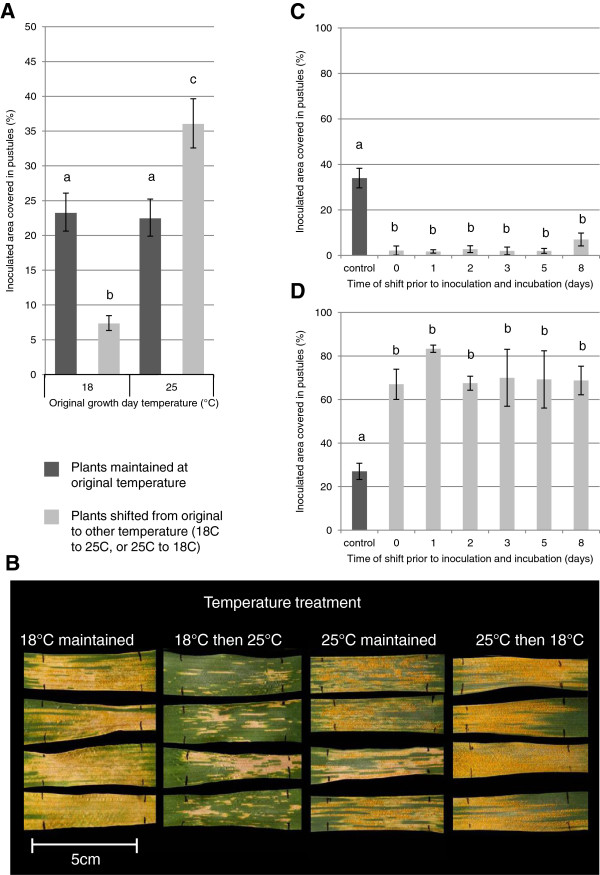
The effect of changes in temperature, up to eight days before inoculation with Pst, on yellow rust resistance in adult plants of the wheat line UC1041 - Yr36. A) Mean percentage (%) leaf area covered in uredia 18 dpi on adult plants inoculated with Pst isolate 08/21 kept at 12°C/18°C or 12°C/25°C pre and post inoculation (dark grey) or transferred to the other temperature regime post-inoculation (light grey). Mean values (± 1 standard error) were obtained from three independent experiments. Different letters indicate statistical significant differences (P < 0.01). B)Pst symptoms on flag leaves at 18 dpi in the four temperature regimes. Uredia can be observed within necrotic/chlorotic areas. C-D) Mean percentage (%) leaf area covered in uredia at 18 dpi on adult plants inoculated with Pst isolate 08/21 and kept at the original temperature regime of C) 12°C/18°C or D) 12°C/25°C pre and post inoculation (dark grey) or shifted at various time points before inoculation to the other temperature regime (light grey). Mean values (± 1 standard error) were obtained from four biological replicates. Different letters indicate statistically significant differences (P < 0.01).